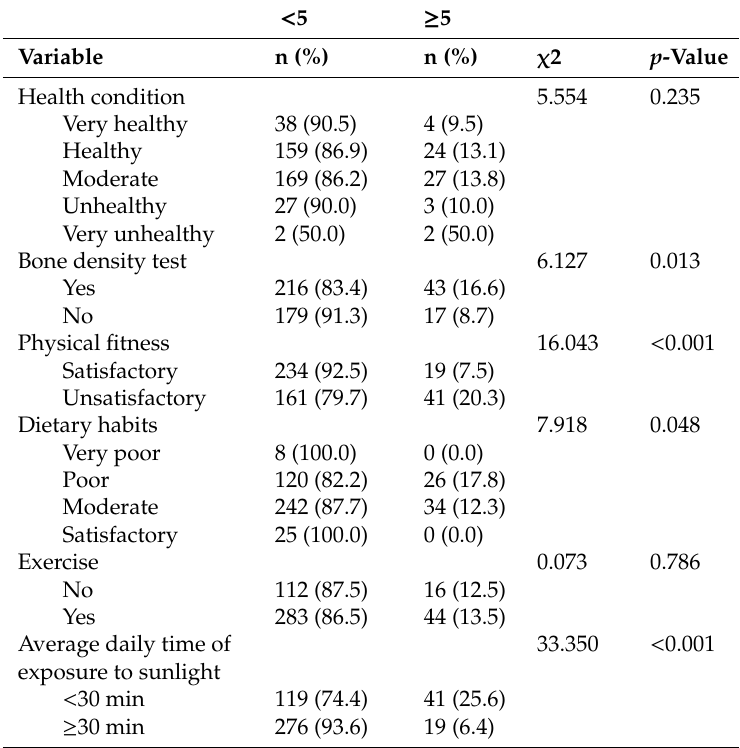
Table 5. Univariate analysis of healthy lifestyle and osteoporosis risk (n = 455).